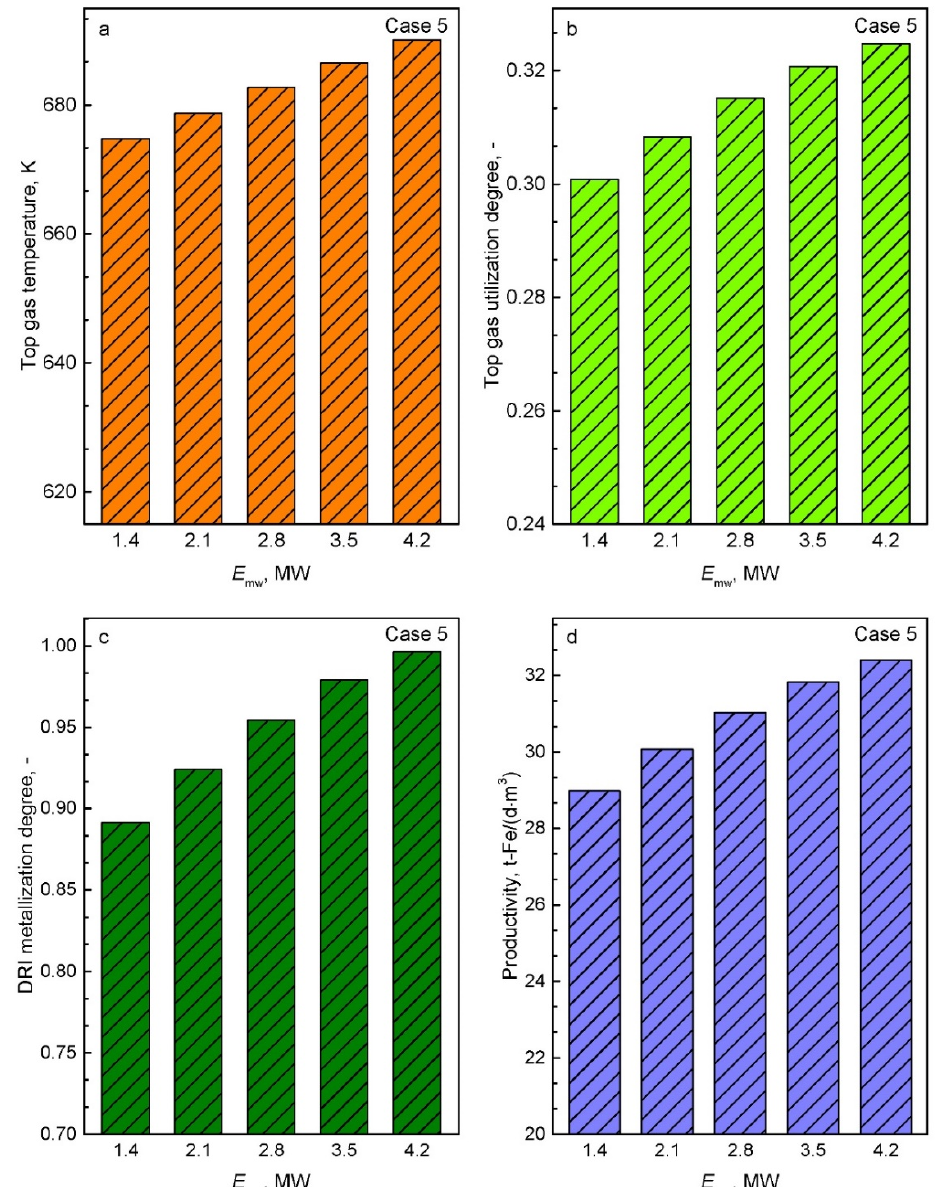
Figure 7. Effects of microwave heating power ( E mw ) on predicted performance indices: top gas temperature ( a ), top gas utilization degree ( b ), DRI metallization degree ( c ) and productivity ( d ).